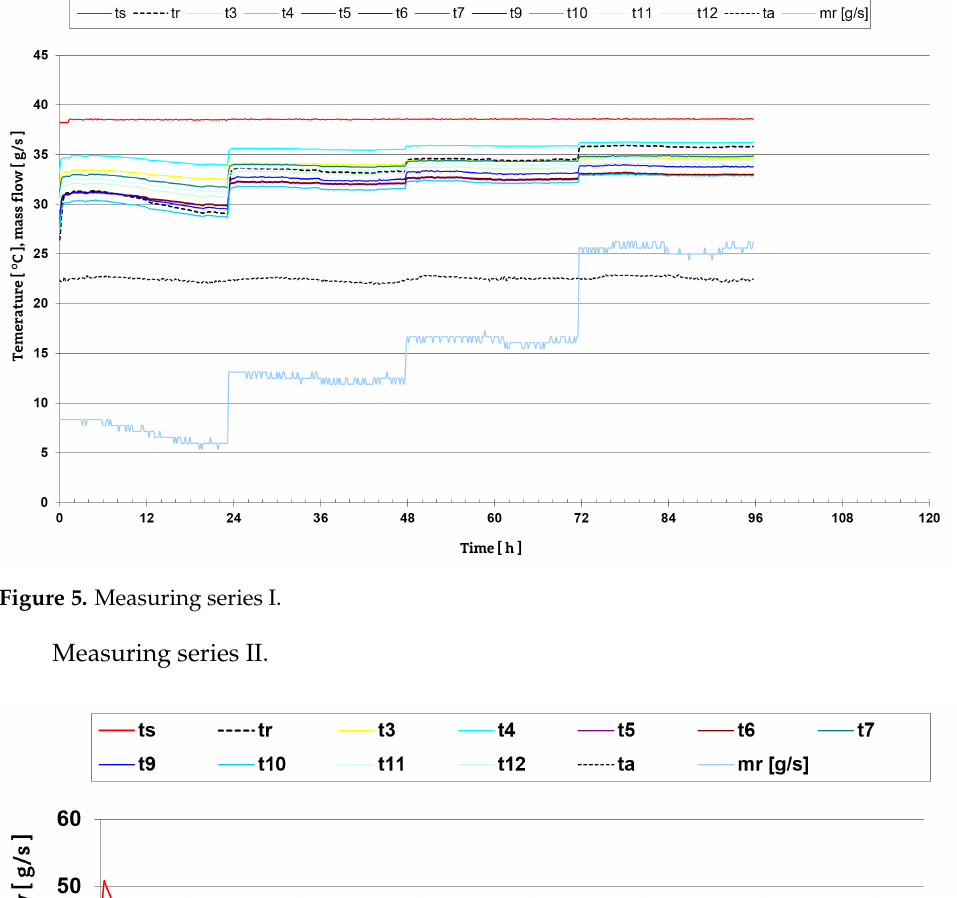
Figure 5. Measuring series I. Measuring series II.